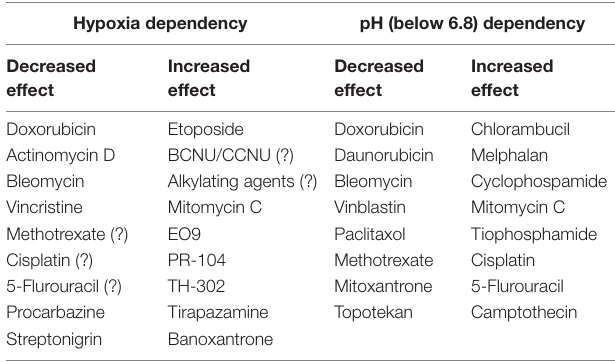
TABLe 3 | influence of the hostile tumor microenvironment on the activity of chemotherapeutic drugs. Hypoxia dependency pH (below 6.8)